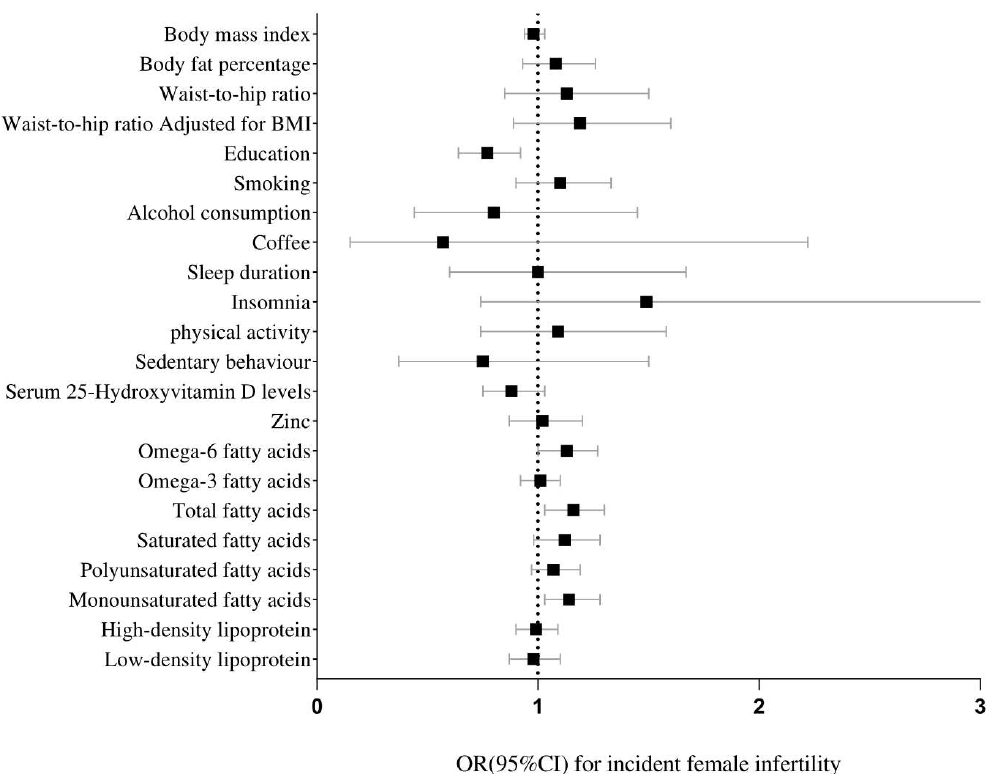
Figure 1. Forest plot of MR analysis between modifiable risk factors and female infertility.